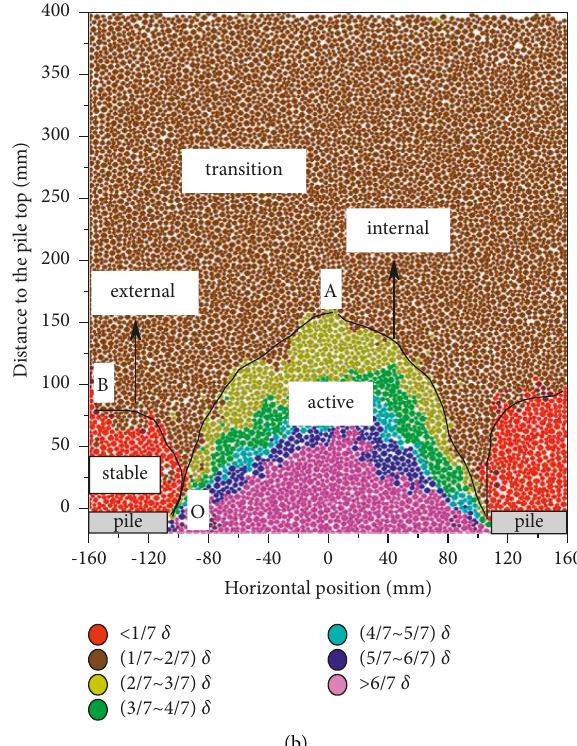
Figure 8: Displacement contour of case1A (s � 320mm, (h � 400mm): (a) development of soil displacement and (b) zone division of final displacement